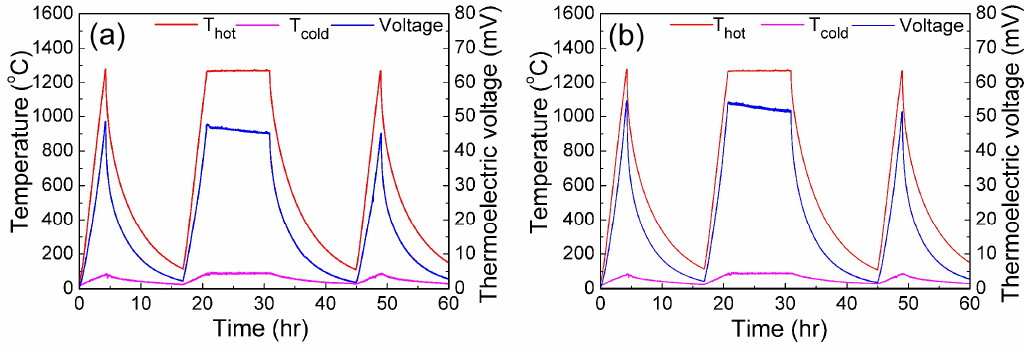
Figure 6. Thermal responses of the thin film thermocouples: ( a ) without glass additives; ( b ) with 8 wt % glass additives.